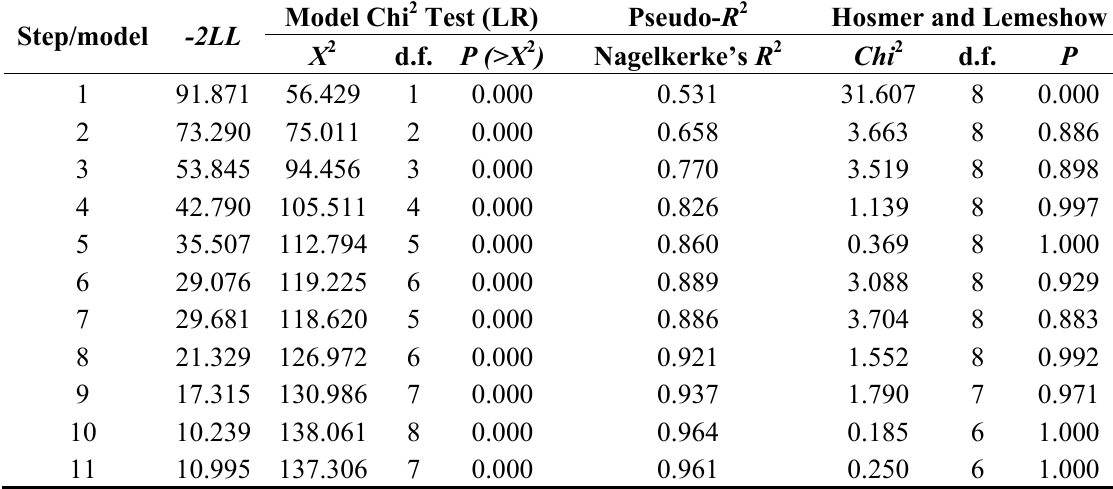
Table 7. Logistic regression models including the log likelihood ( -2LL ), model chi 2 test (LR), degrees of freedom ( d.f. ), significance level ( P ), pseudo- R 2 statistics and Hosmer and Lemeshow